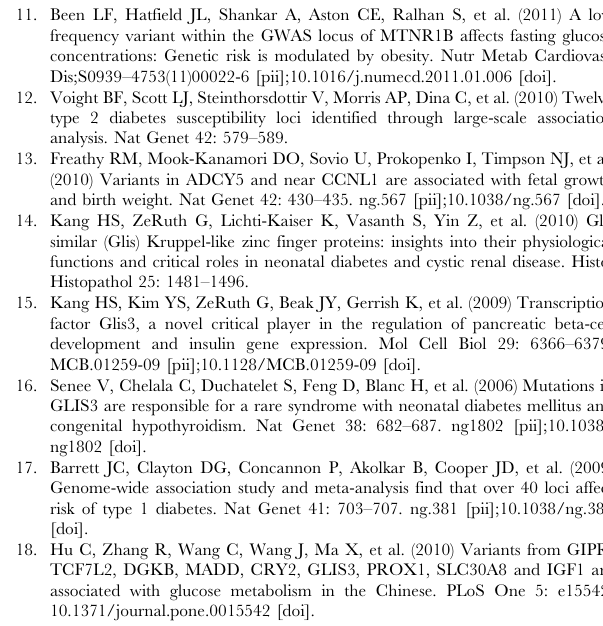
Table S1 Genotype distributions in the UKADS